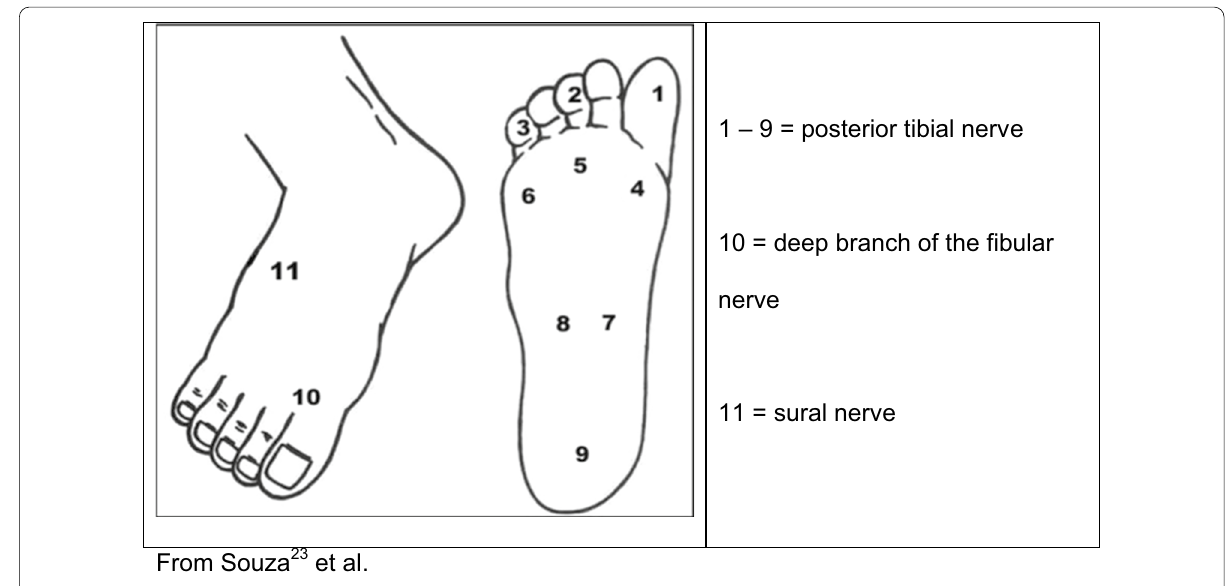
Fig. 1 Visual representation of the cutaneous points for sensitivity assessment. From Souza et al.